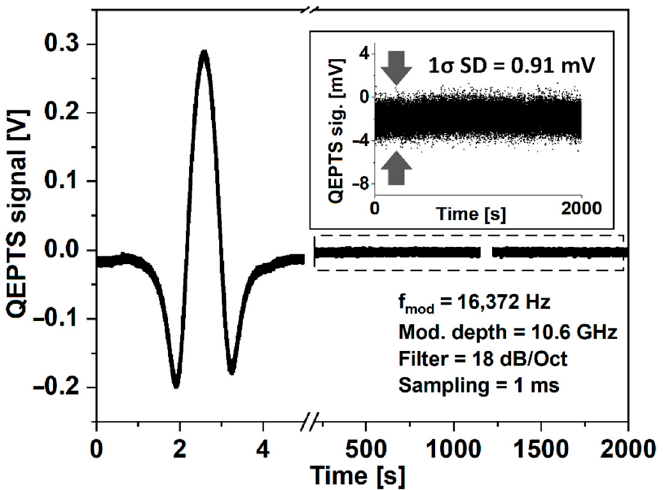
Figure 6. The QEPTS signal recorded for 2000 ppmv of CH 4 in the ARHCF acquired with optimal modulation parameters was followed by a 2000 s noise amplitude measurement registered with N 2 in the fiber. The inset shows a close-up of the registered noise amplitude for clarity.